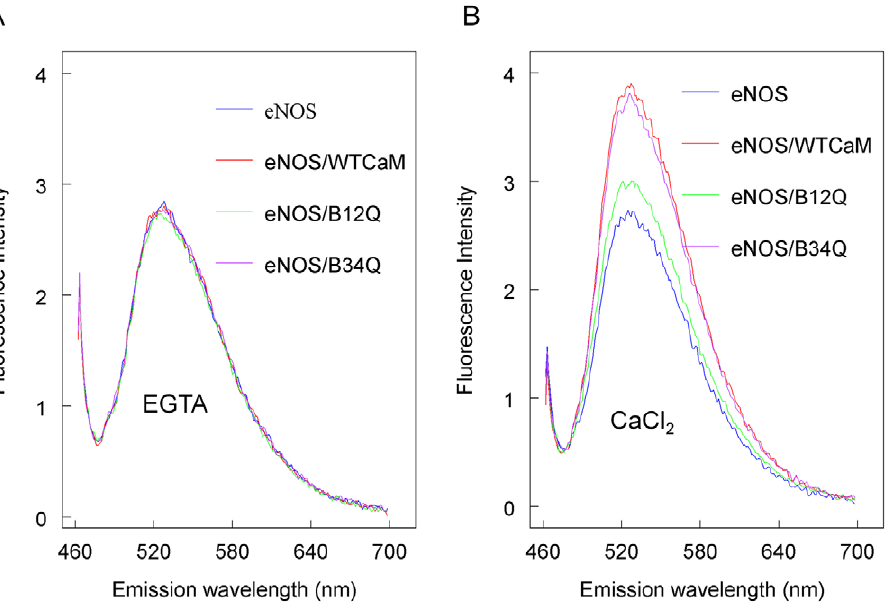
Figure 5. Flavin fluorescence of eNOS treated with wild-type and CaM mutants. A: Fluorescence emission spectra of eNOS were obtained in a solution containing 25 mM Tris, pH 7.5, 100 mM NaCl, 0.1 mM DTT, , 6 m M eNOS and , 12 m M of wild-type CaM, B 12Q or B 34Q in the presence of 2 mM EGTA. B: The change of fluorescence intensity for wild-type CaM, B 12Q or B 34Q was recorded upon addition of 2.5 mM CaCl 2 to the above mixtures. Excitation wavelength was set at 455 nm. The fluorescence data were corrected by subtracting CaM and buffer effects. The eNOS alone and eNOS-CaM complex are indicated in each plot.